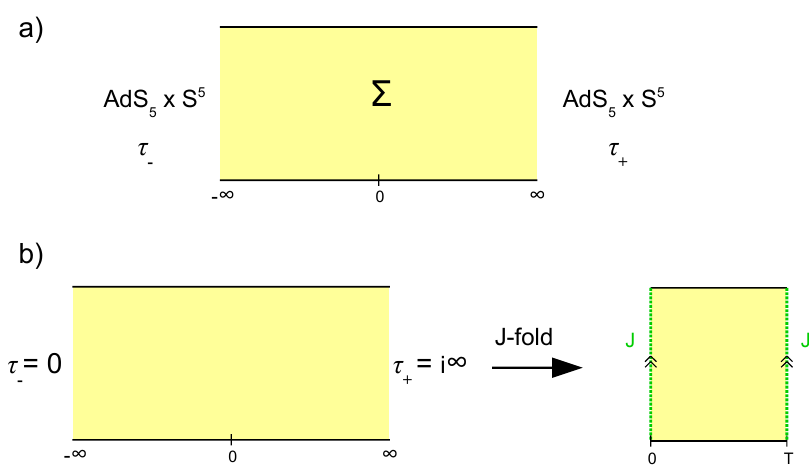
Figure 1 . a) Picture of (cid:6) (yellow strip) for the Janus solution with asymptotic axio-dilaton values (cid:28) (cid:6) . b) J -folding of the extremal Janus solution. This involves an SL(2 ; R ) transformation